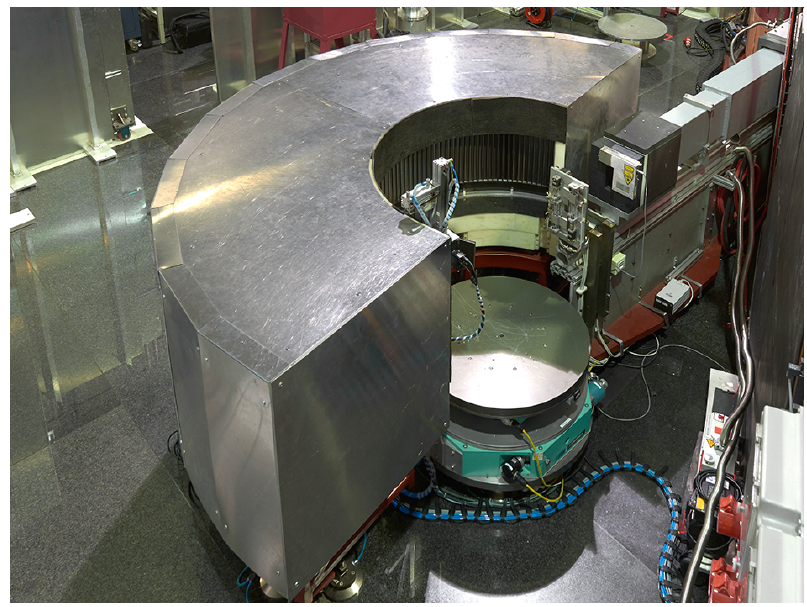
Figure 1: Instrument SPODI (Copyright by W. Schürmann,